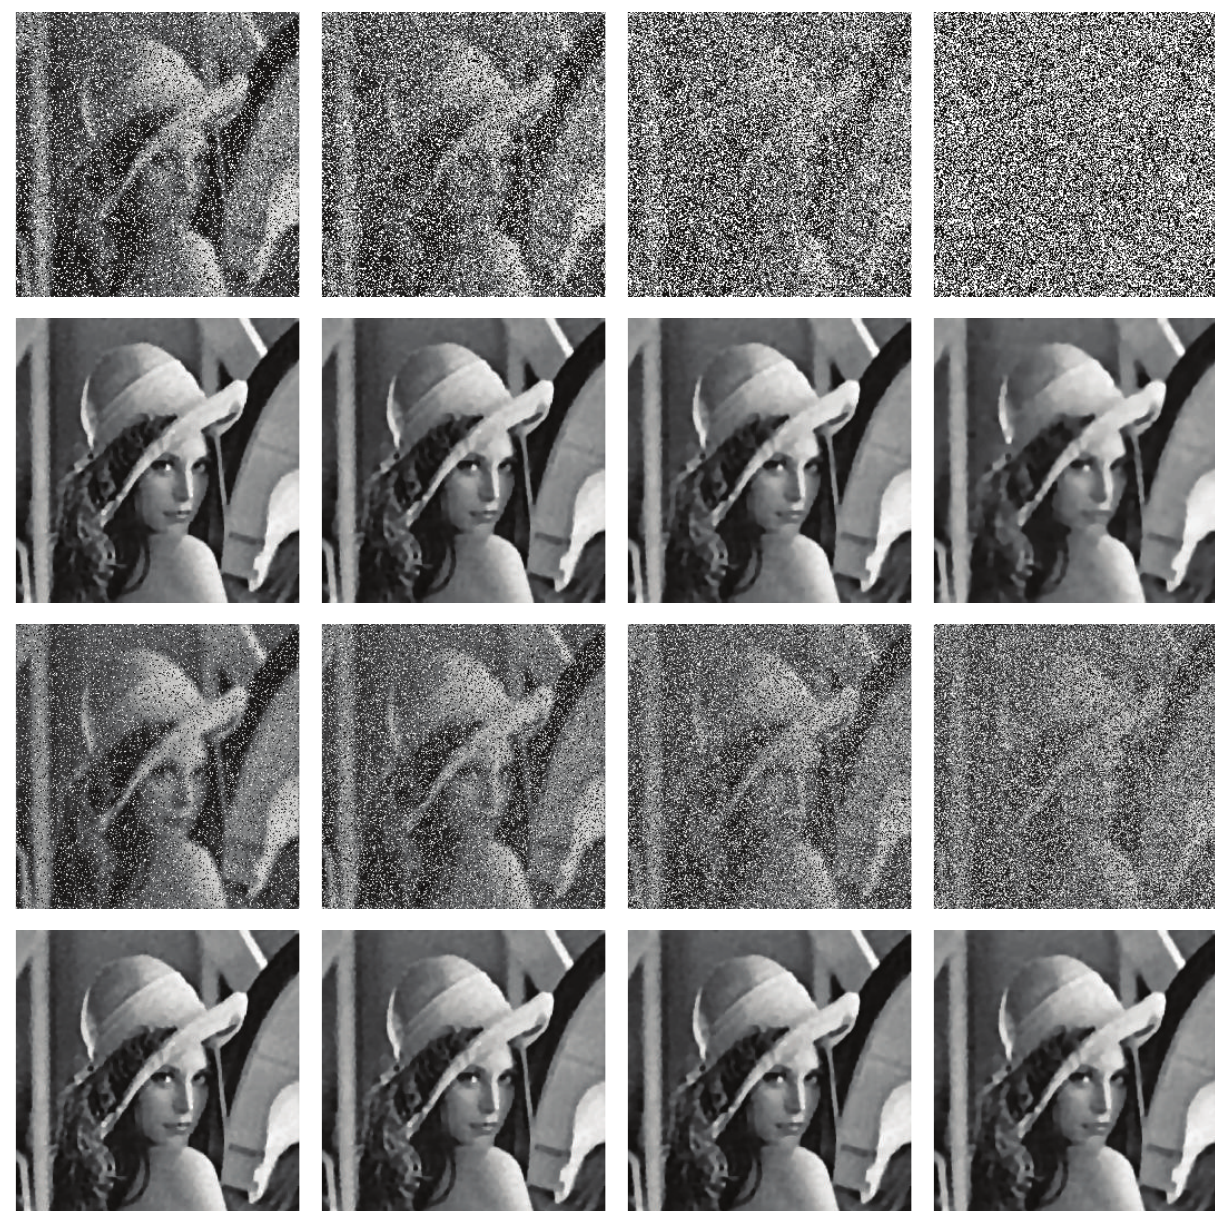
Figure 4: Top: Lena image blurred with out-of-focus kernel of radius 3 and then corrupted by Gaussian noise with 𝜎 = 5 and salt-and-pepper noise with 𝑠 = 30 %, 50%, 70%, and 90 %, respectively. The second line: results restored by MNID-ADMM ( 𝛼 1 = 0.9 , 𝛽 1 = 𝛽 2 = 𝛽 3 = 0.05 ). The third line: Lena image blurred with out-of-focus kernel of radius 3 and then corrupted by Gaussian noise with 𝜎 = 5 and random-valued noise with 𝑟 = 25 % , 40 % , 55 %, and 70 %, respectively. Bottom: results restored by MNID-ADMM ( 𝛼 1 = 0.9 , 𝛽 1 = 𝛽 2 = 𝛽 3 = 0.05